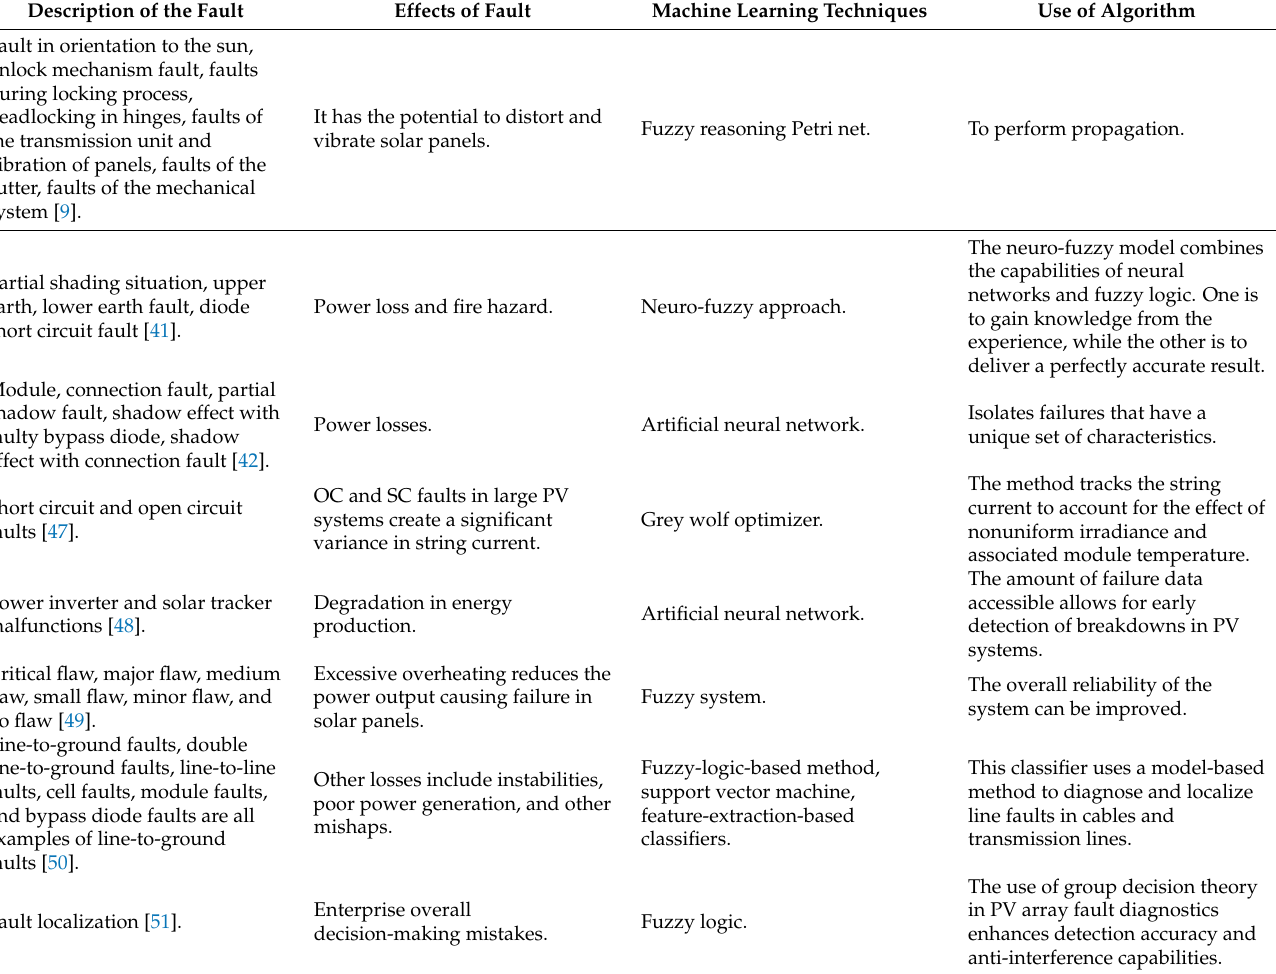
Table 2. Wide range of comparisons between machine learning techniques of various